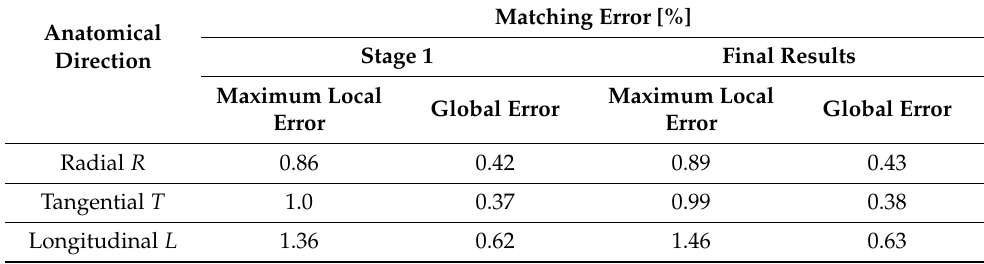
Table 3. Matching errors of the final results and of the first calculation stage for the pine samples.